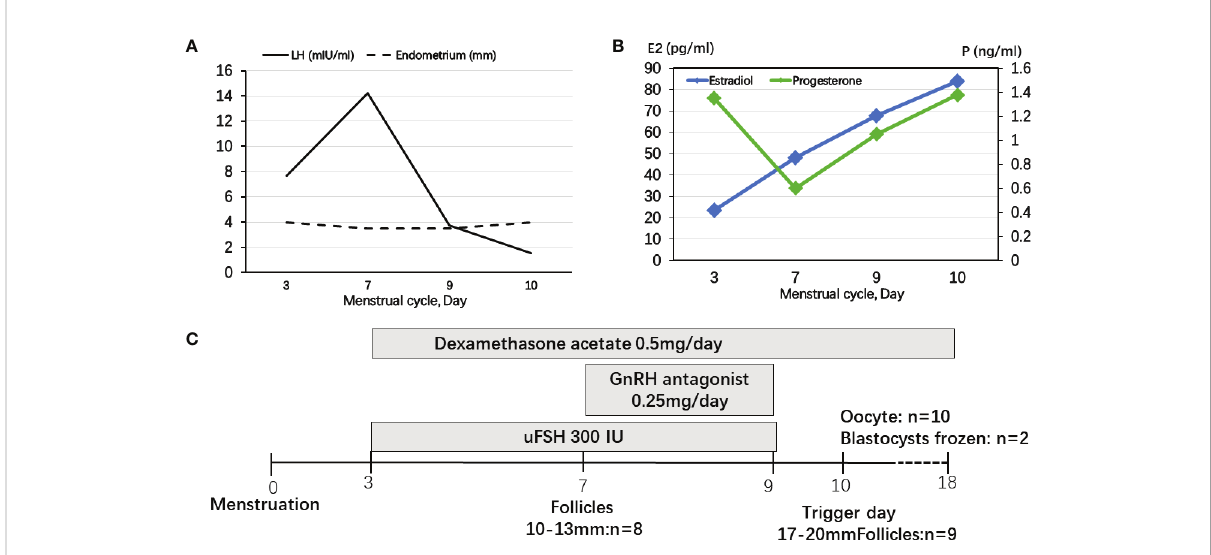
FIGURE 2 Controlled ovarian stimulation cycle in patient 2. (A) LH levels were elevated at the fourth day of FSH stimulating and decreased after using GnRH antagonist. The endometrium was less than 5 mm during COH. (B) During FSH stimulation, serum E2 levels were only modestly increased and P4 levels were controlled by dexamethasone. (C) The start dose was uFSH 300 IU for 4 days and then GnRH antagonist 0.25 mg was added until the day before the trigger